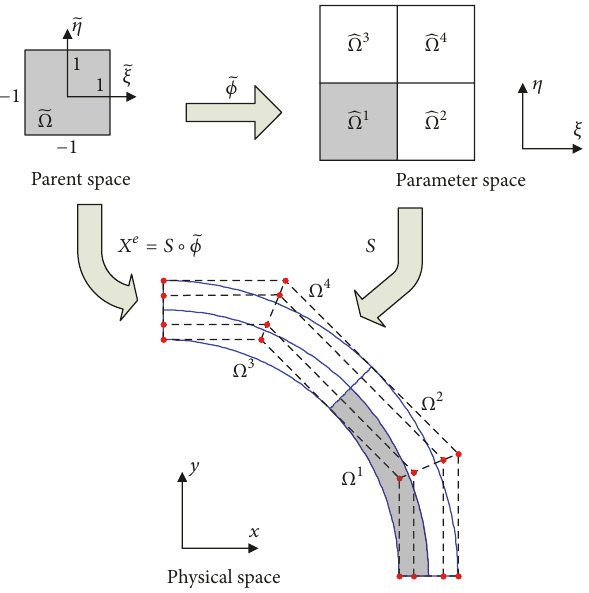
Figure 4: The mappings among parent space, parametric space, and physical space.